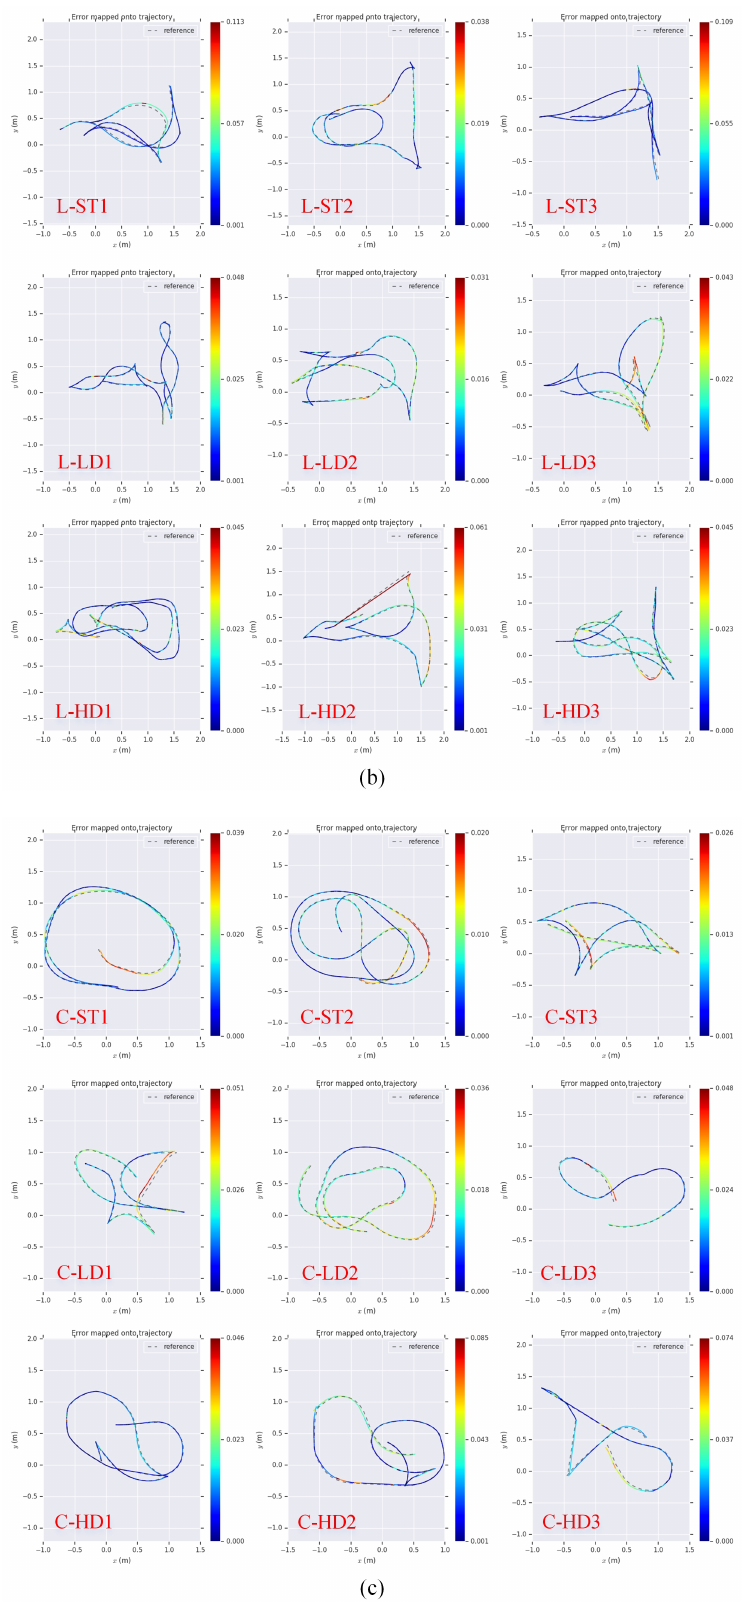
Figure 10. Comparison of the trajectories of the proposed method with the ground truth in the ( a ) office, ( b ) lab, and ( c ) corridor environments. The absolute pose errors are encoded by